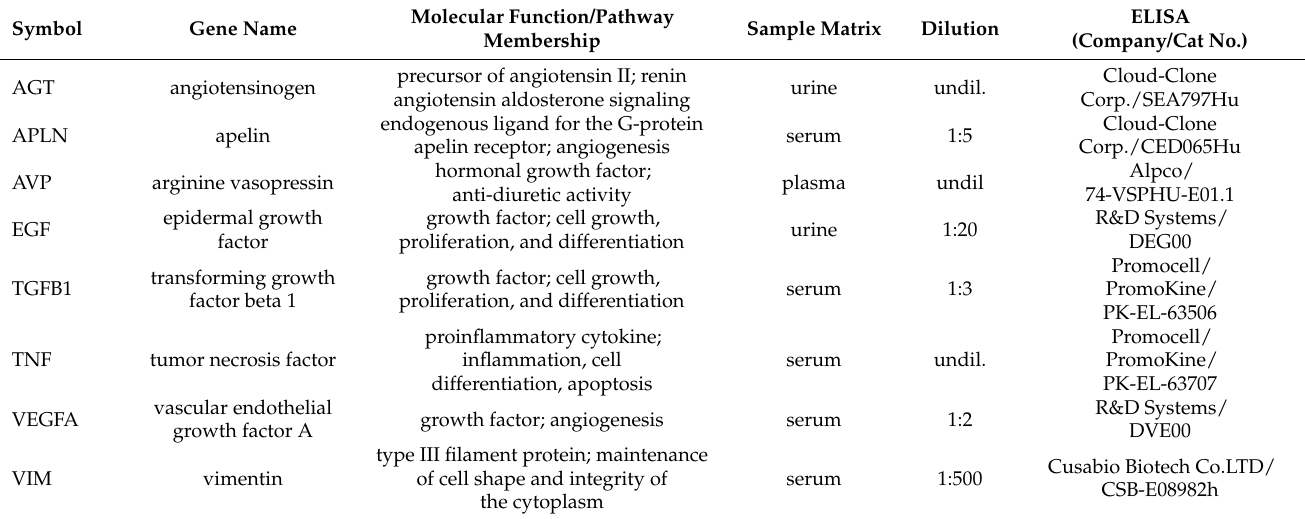
Table 2. Listing of the 8 selected biomarkers along with information on molecular function and pathway assignment. Information on ELISAs used for measurements, sample matrix and dilution is provided in